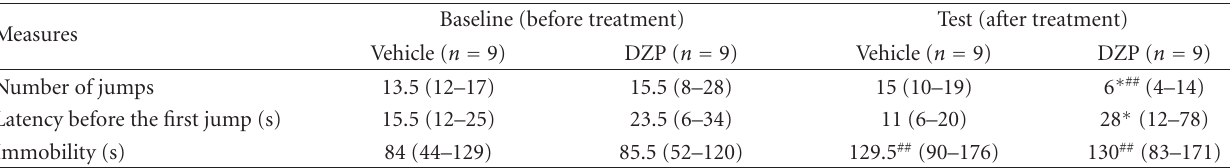
Table 4: E ff ects of acute diazepam (DZP) treatment (3mg/kg, IP, n = 9, median with limits of interquartile range values).